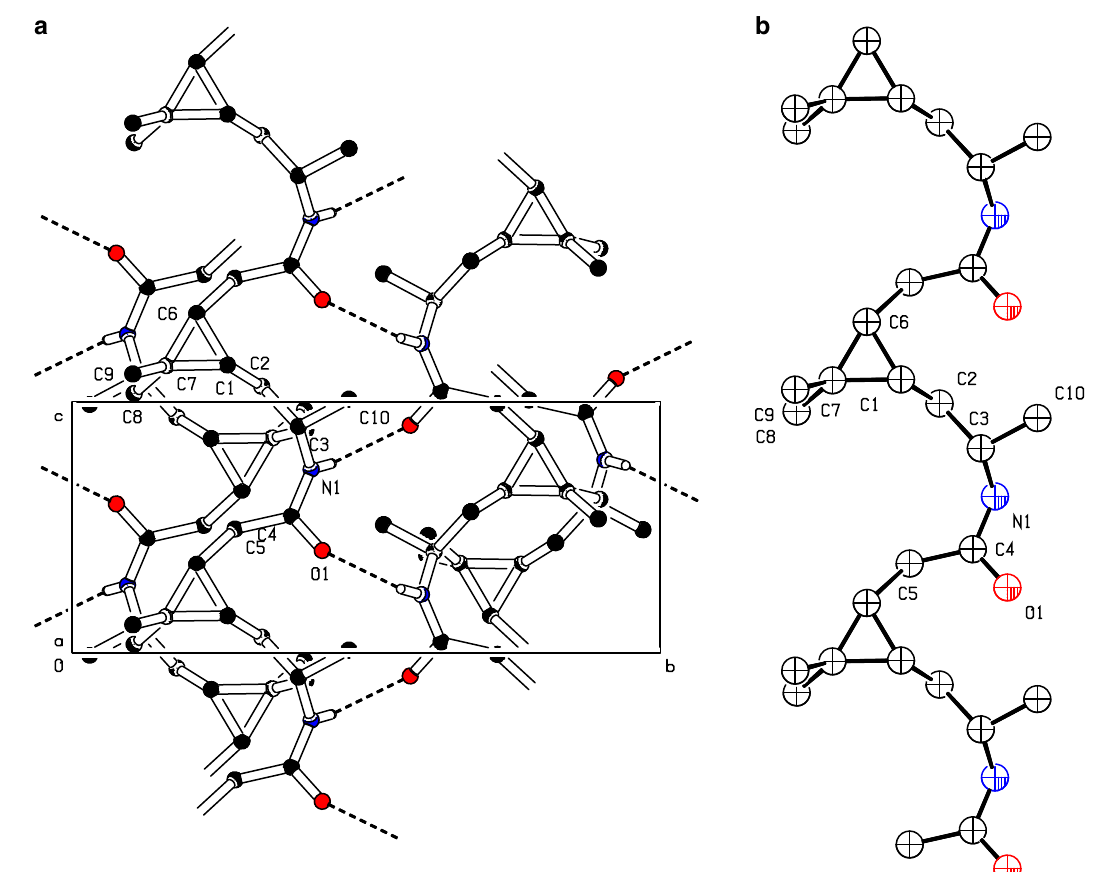
Fig. 10 Crystal structure of poly5-3S. Structure of poly5-3S , viewed in unit cell direction a ( a ) and the expanded repeating unit ( b ). In the unit cell view, only bonding hydrogens are